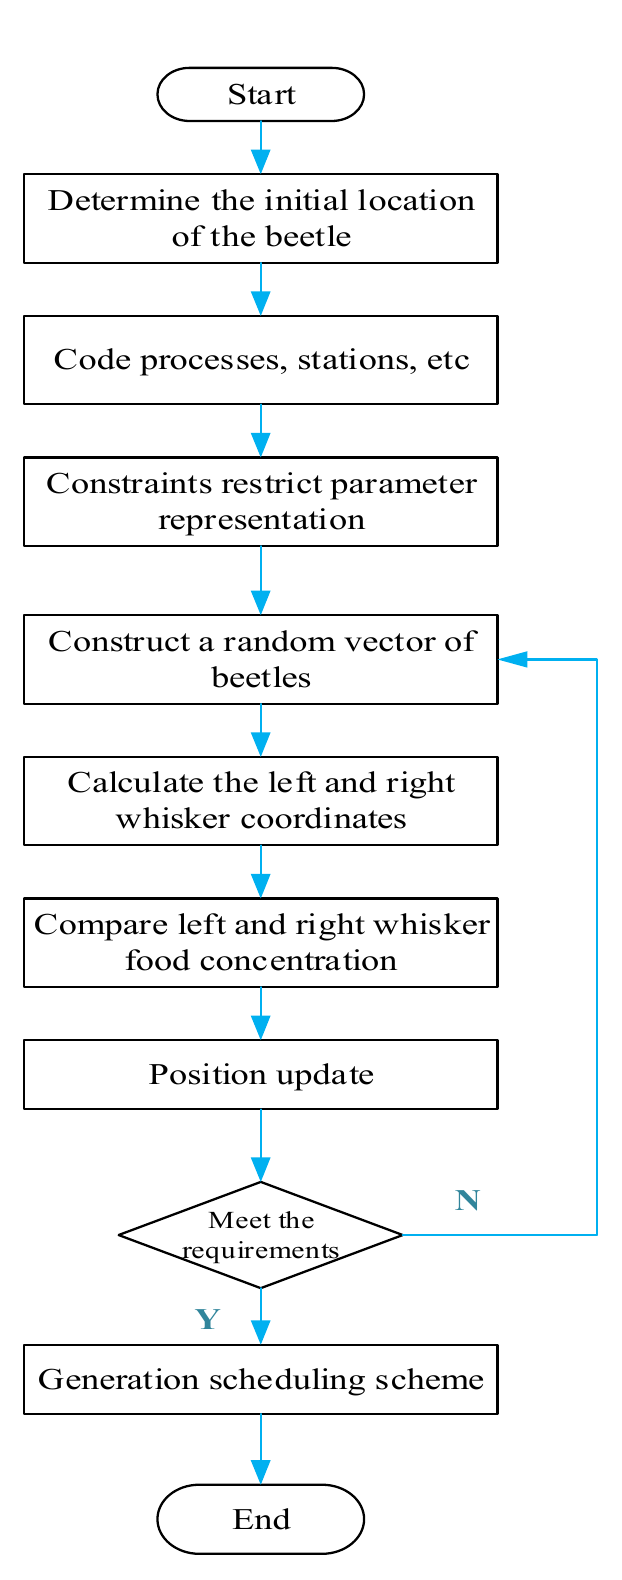
Figure 3. Algorithm flow diagram combined with the process diagram. The non-fixed point discrete division method is a new method to determine time nodes in the time domain. It is based on the control parameterization idea of the piecewise constant method. The method is to randomly select n time interval points, t i , i = 1, 2, . . . , n , (cid:104) (cid:105) t 0 , t f within the time interval between the beginning and the end of the reaction